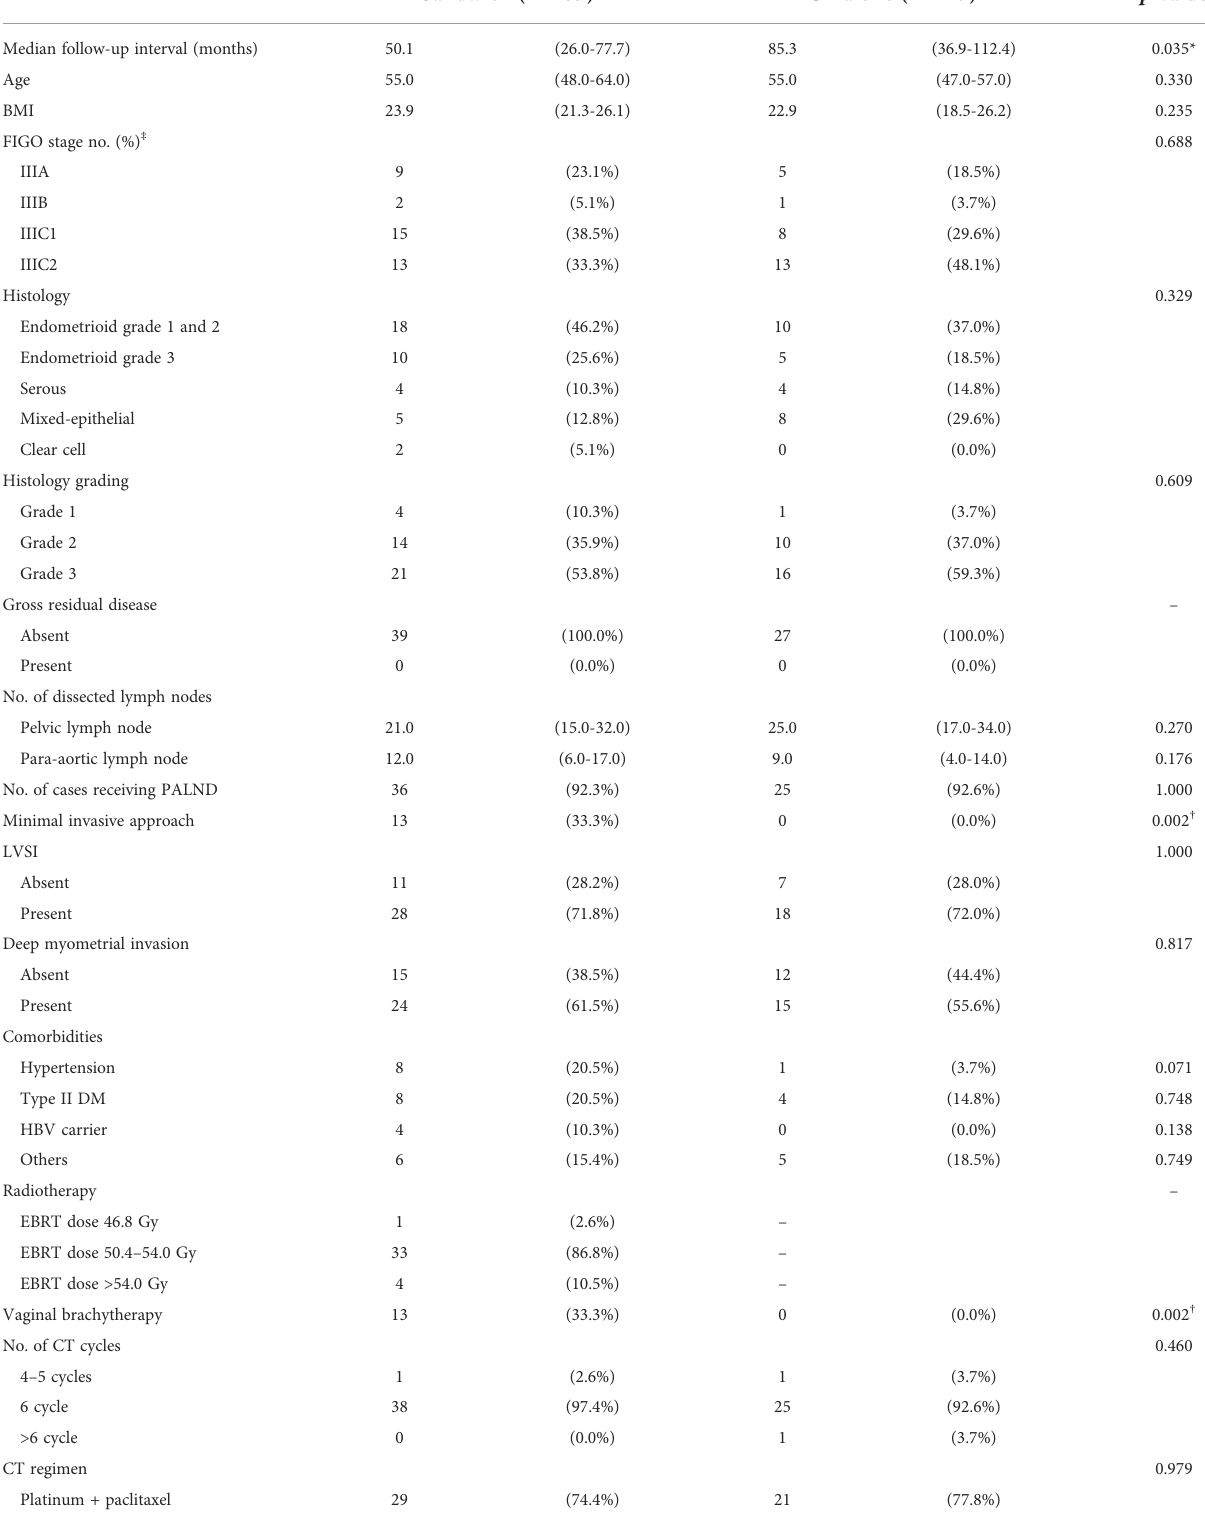
TABLE 1 Characteristics of the patients (N =